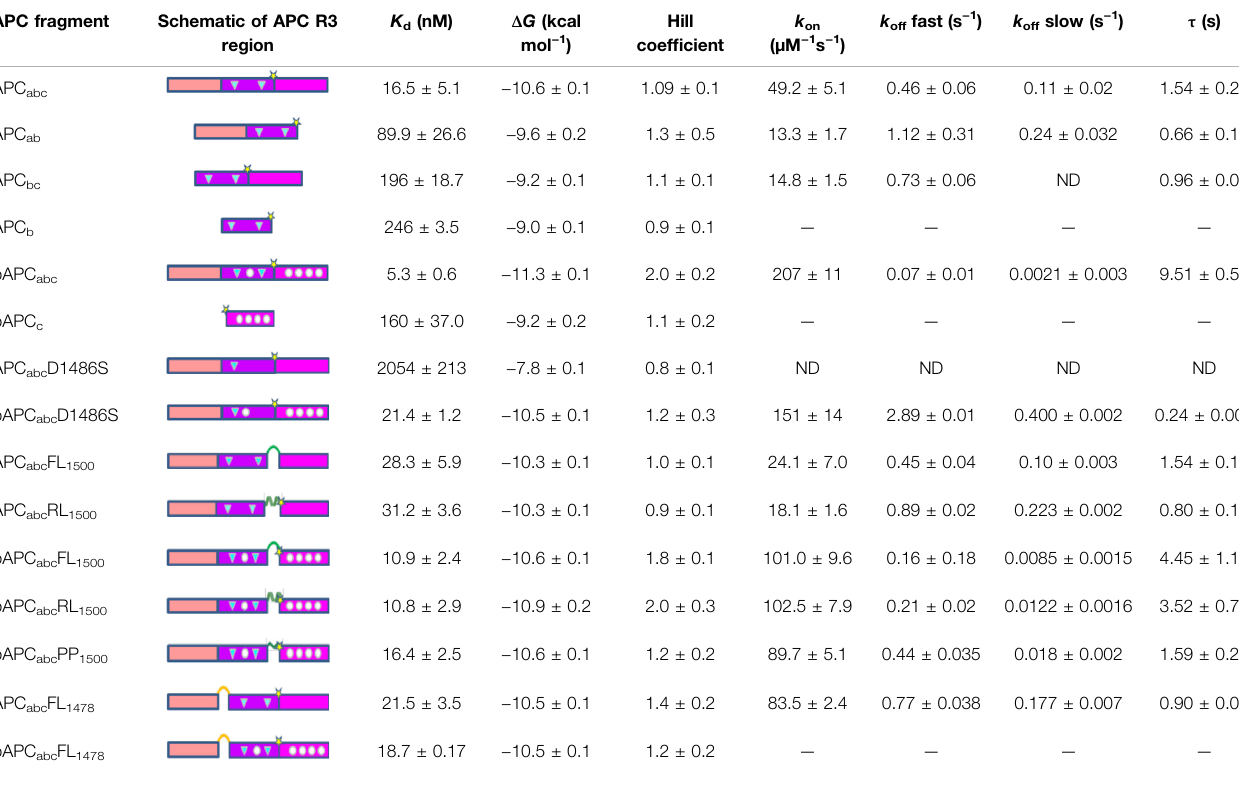
TABLE 1 | Effects of mutations, truncations and insertions in APC Repeat 3 region on the interaction with β -catenin. p-APC indicates phosphomimetic mutations, APC indicates non-phosphorylated form. Presence or deletion of subdomains a, b and c is indicated in subscript. FL indicates fl exible linker, RL indicates rigid linker, PP indicates polyproline linker (see also Figure 5A ), and the site of linker insertion is indicated in subscript. In the schematics, the key contacting residues are denoted in circles (phosphomimetics)andtriangles(lysine-bindingresidues).NDindicatesnotdetectable.Thevaluesof K d , Δ G andHillcoef fi cientarederivedfromthe fl uorescenceanisotropy experiments.Theon-andoff-ratesandtimeconstant( τ ,calculatedfromthefastoff-rates)weredeterminedbystopped- fl ow fl uorescenceexperiments.NDindicatesnot detectable. The SE error come from at least three